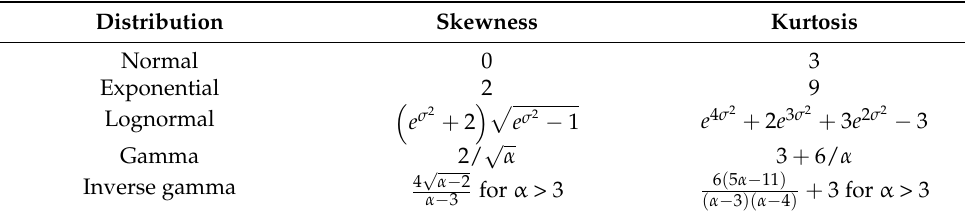
Table 2. Skewness and kurtosis of a number of typical distribution functions. Distribution